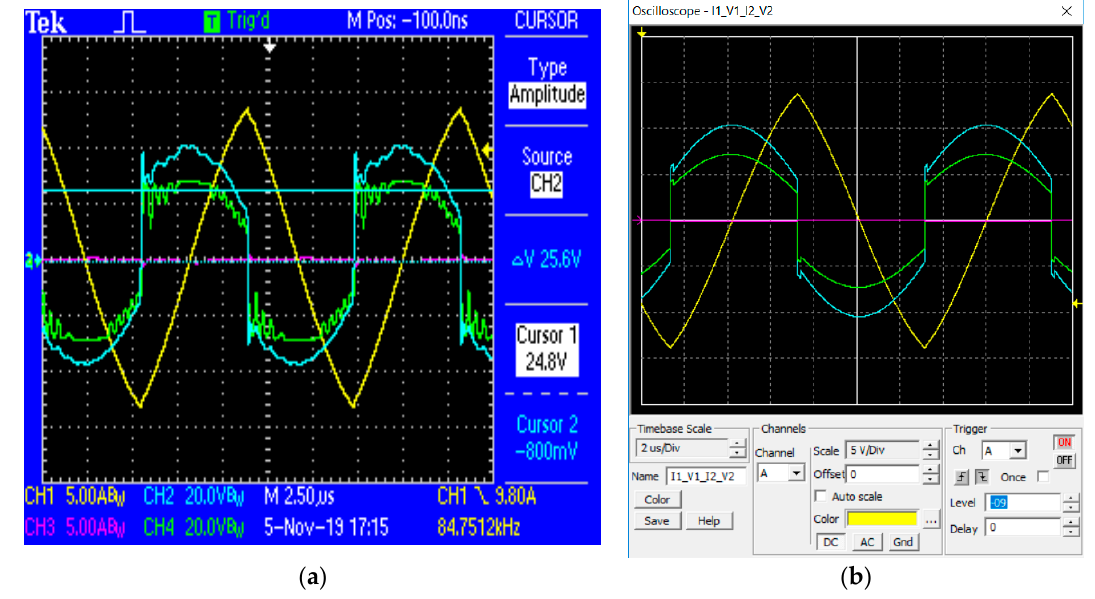
Figure 13. Testing the open secondary load exception: ( a ) Screen-print of the oscilloscope; ( b ) Print screen of simulation with PSIM software. Same channels in ( a , b ), which corresponds to the same signals.